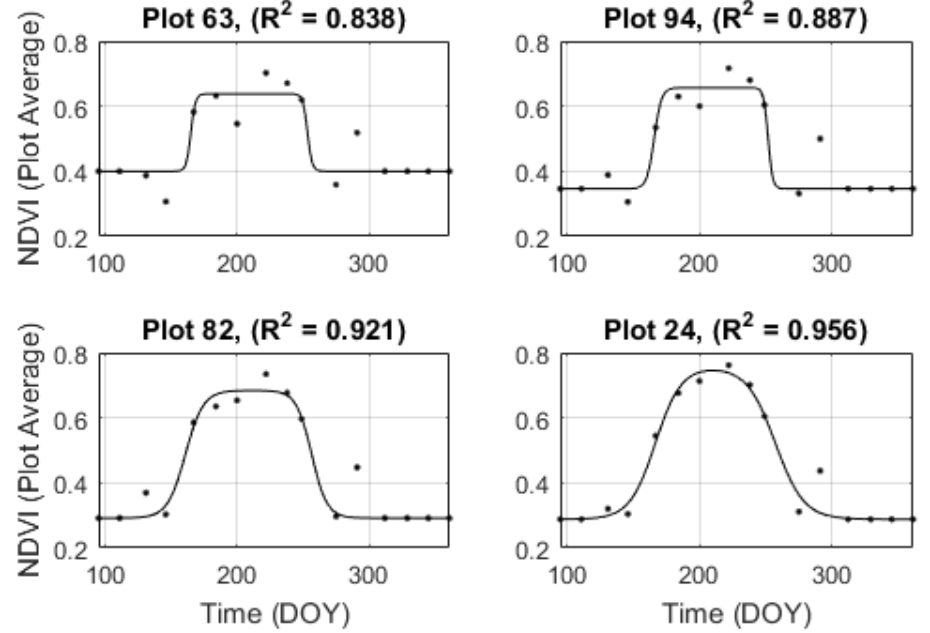
Figure 7. Four different plot-average NDVI time-series resampled to an 18-day average revisit interval and fit to the asymmetric double sigmoid function.